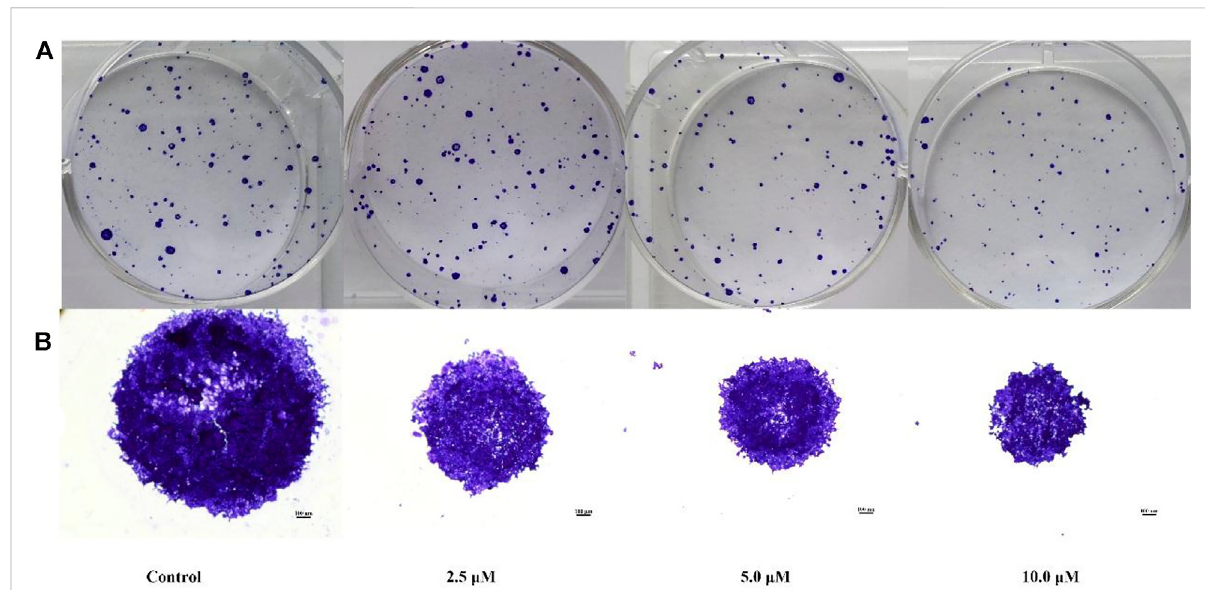
FIGURE 3 ColonyformationofHCT116cells inhibited bycompound E . (A) HCT116 cellswereincubatedwithvaryingconcentrations of E (0,2.5,5,10 μ M) and stained with crystal violet. (B) The micrographic differences betweenthecolonies. Imageswere taken ofstained single colonies observedunder a